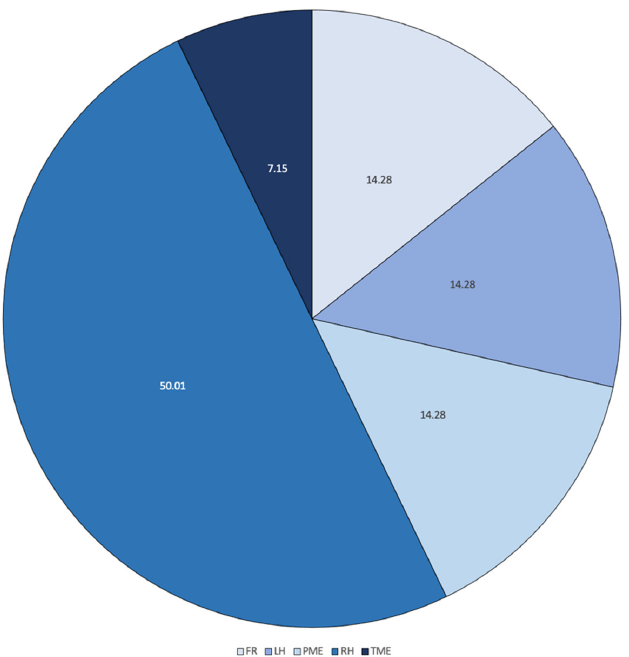
Figure 3. Frequency distribution of different types of resections performed on patients (FR: flexure resection, LH: left hemicolectomy, RH: right hemicolectomy, PME: partial mesorectal excision, TME: total mesorectal excision).